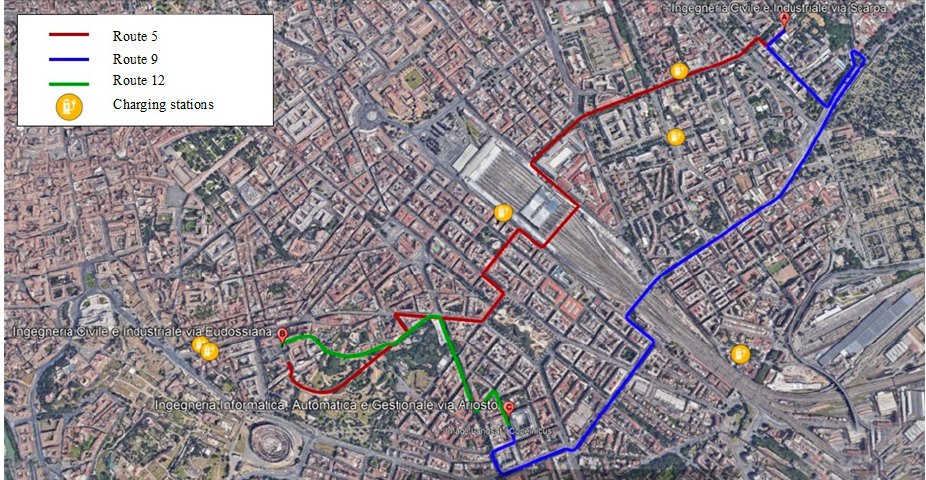
Figure 15. Google Earth map of the multi-point route selected by the software: route 5 in red; route 12 in green; route 9 in blue; charging stations installed near the route in